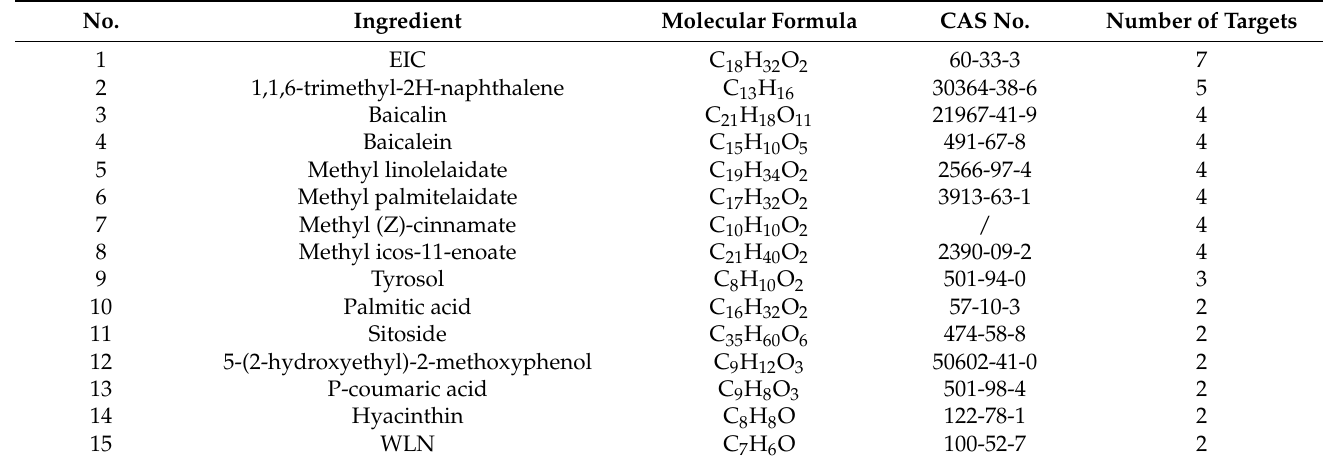
Table 3. The chemical information of active ingredients for Scutellariae